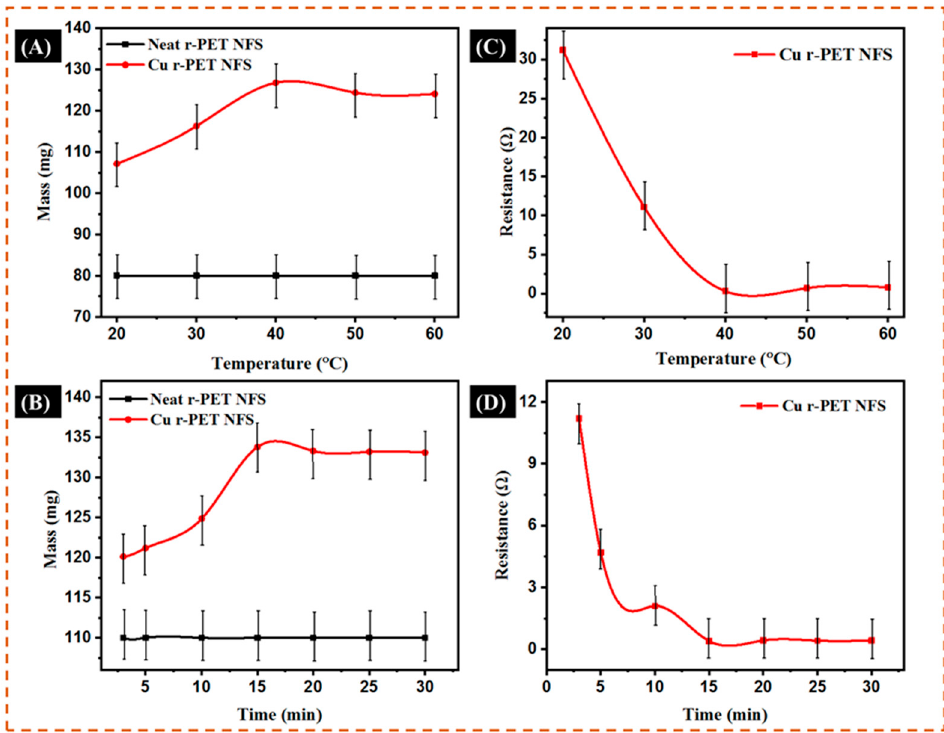
Figure 6. ( A ) The effect of the weight of the r-PET nanofibers as a function of temperature; ( B ) the effect of the resistance of the r-PET nanofibers as a function of temperature; ( C ) the effect of the weight of the r-PET nanofibers as a function of electroless deposition time; ( D ) the effect of the resistance of the r-PET nanofibers as a function of electroless deposition time.